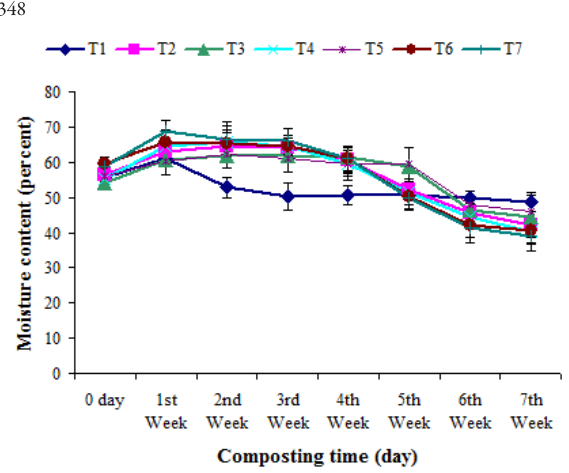
Fig. 1. Changes of Moisture content (%) during composting of press mud. T : Control (Without microorganism); T 1 : PM + Salmonella sp.+ CM; T Enterobacter sp. + CM; T 3 + Proteus sp. + CM; T : PM + Klebsiella sp.+ CM; T 5 : PM+ Consortium+ CM Cellulomonas sp. + CM; T 7